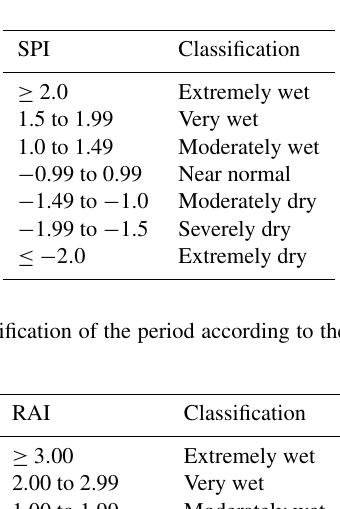
Table 4. Classification of drought conditions according to the PN values.